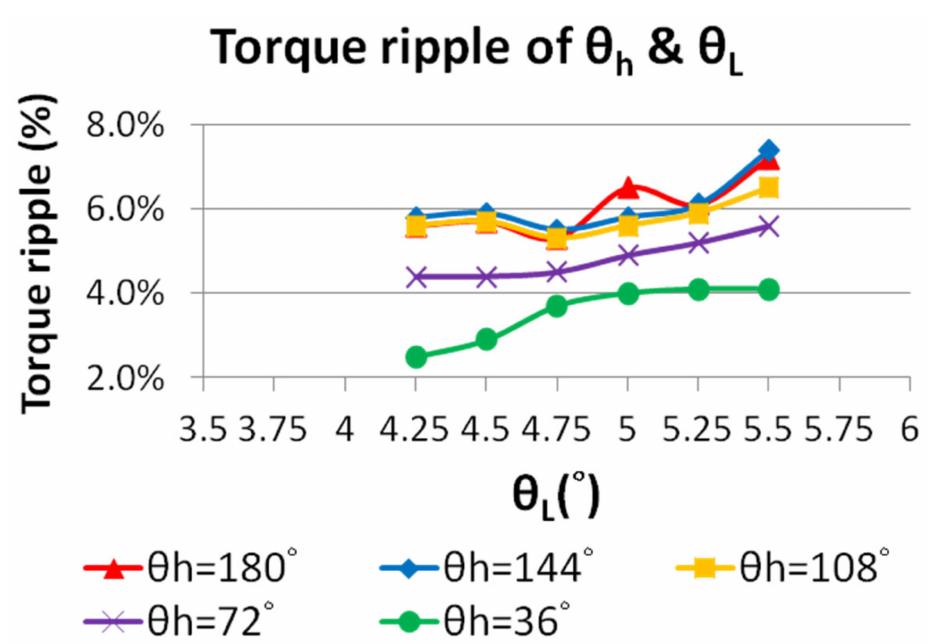
Figure 12. Maximum torque variation with θ h and θ L .